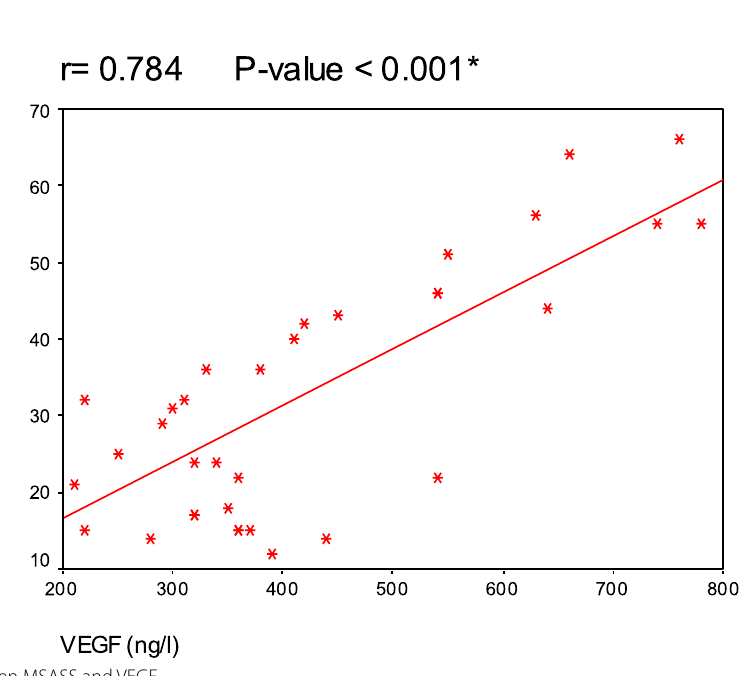
Fig. 4 Correlation between sacroiliac x-ray score and VEGF